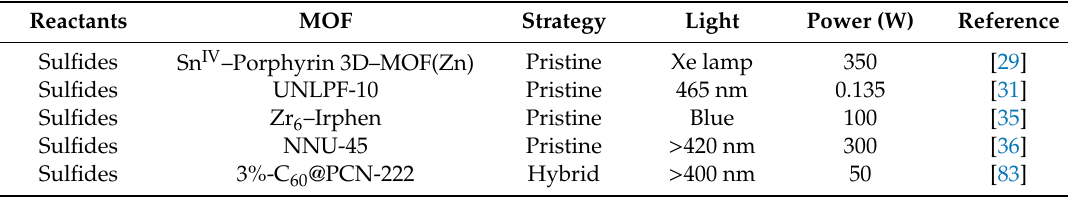
Table 3. Photosulfoxidation reactions mediated by